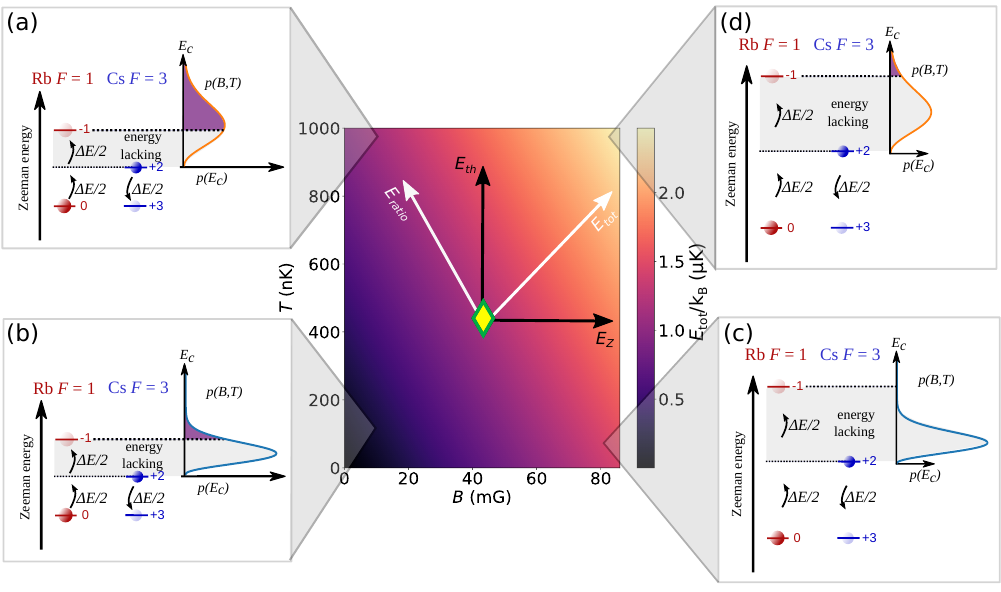
Figure 2: Parameter space of single-atom spin probing. The parameter space is spanned by the pairs B , T , and E , E of independent variables to be sensed. They tot ratio can be visualized as a coordinate system, where for a given point to be sensed, one parameter is kept fix, while the independent parameter (orthogonal axis) is varied. The total energy E is minimal for low magnetic fields and temperatures (lower left tot corner) and increases when the magnetic field and / or temperature increase. The four sensitivity directions are depicted in the coordinate systems. The diamond marks the reference point at which the sensitivity is evaluated in the following along the four axes of parameter space. Panels (a)-(d) show the energetic competition between thermal and Zeeman energies for endothermal SE processes at selected points in parameter space, and the corresponding contribution to the spin